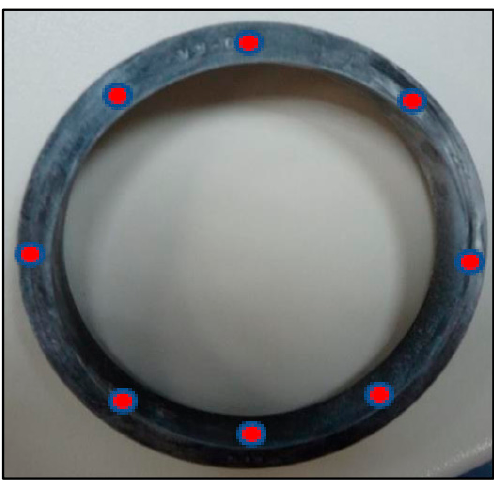
Figure 5. Front view of O-ring and position of indentations